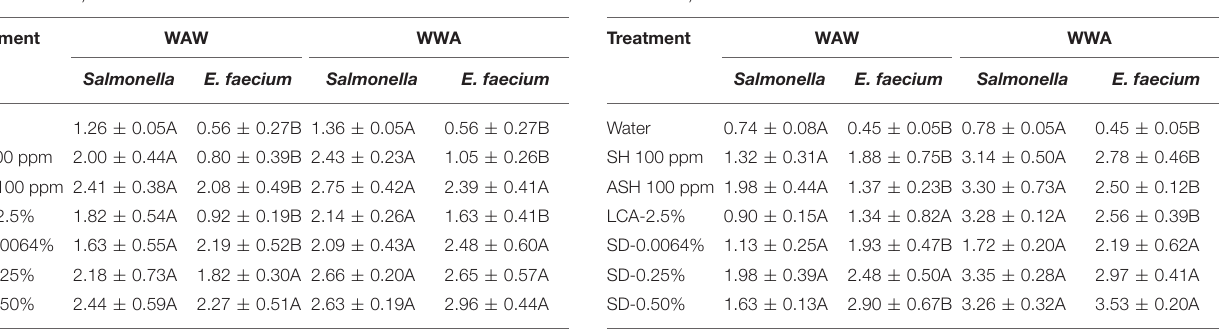
TABLE 8 | A comparison of the reduction of Salmonella and surrogate E. faecium on tomatoes (log CFU/tomato) by triple-wash procedure WAW or WWA in water, SH (100 ppm, pH 8.2), ASH (SH, 100 ppm, pH 6.8 adjusted by citric acid), LCA (Veggiexide ® , 2.5%), and a PAA and hydrogen peroxide mix (SD, 0.0064, 0.25, and